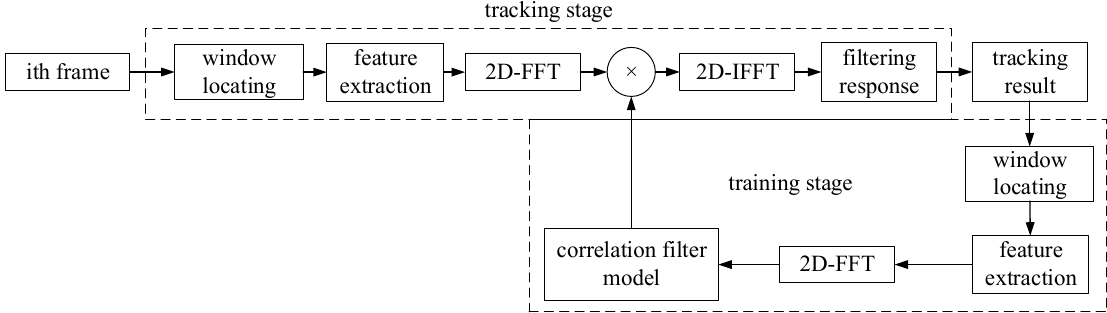
Figure 1. A schematic diagram of KCF. The whole process is divided into two steps: training and tracking. After updating the correlation filter model by the tracking on the last frame, the model can get the tracking result on the current frame. FFT and IFFT respectively denote the Fast Fourier Transform and the Inverse Fast Fourier Transform.